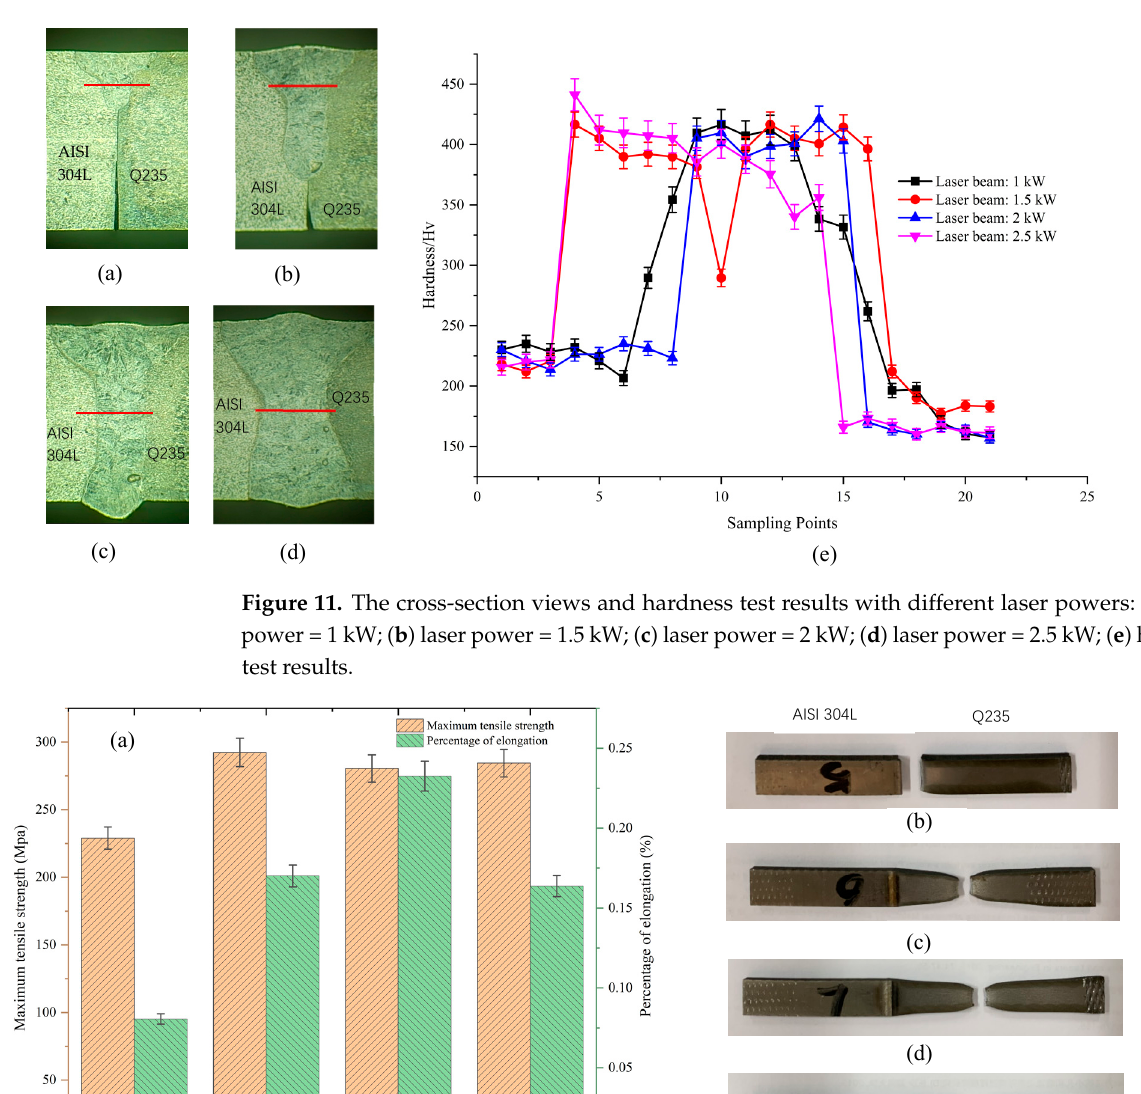
Figure 10. The top views of the simulation results: ( a ) laser power = 1 kW; ( b ) laser power = 1.5 kW; ( c ) laser power = 2 kW; ( d ) laser power = 2.5 kW.